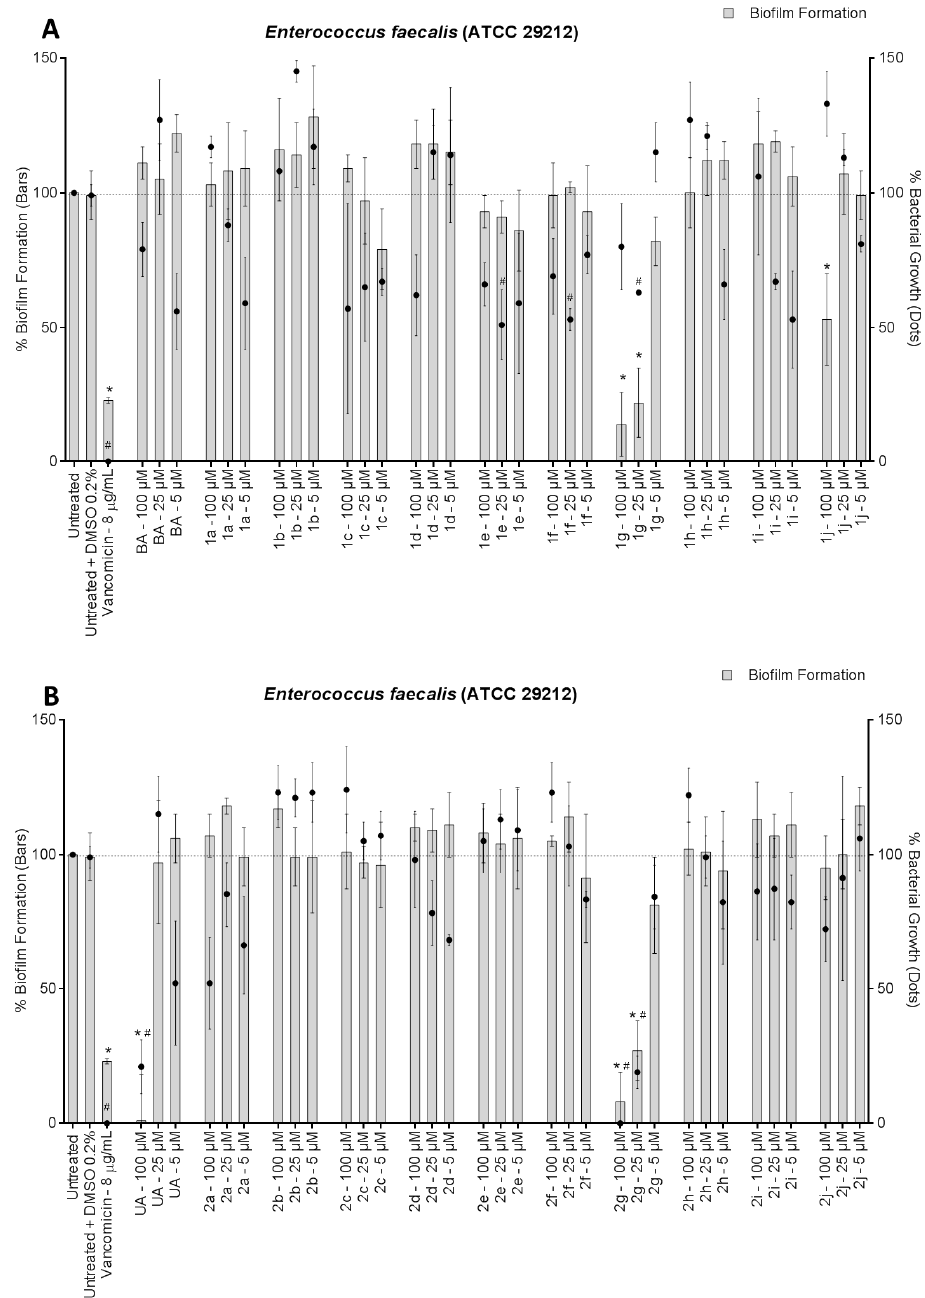
Figure 4. In vitro antibiofilm and antibacterial activity of Enterococcus faecalis : ( A ) BA and derivatives; ( B ) UA and derivatives. The results represent the mean ± standard deviation of five experiments. * Represents a significant difference in relation to the biofilm formation control ( p < 0.01). # Represents a significant difference in relation to the planktonic cells’ viability control ( p < 0.01).